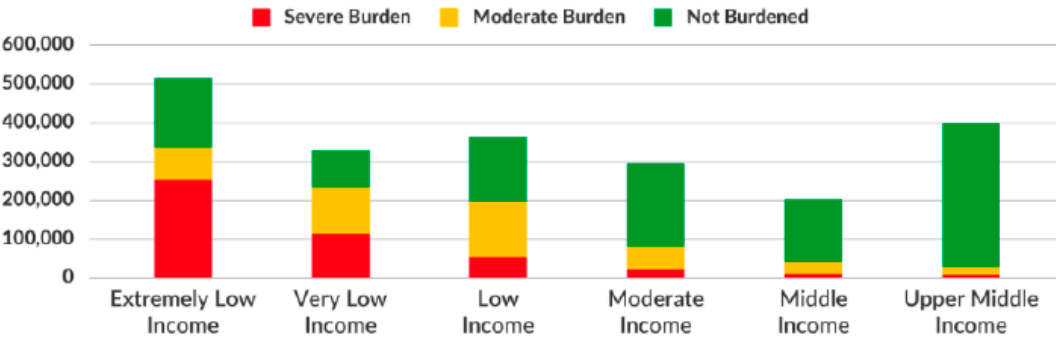
Figure 2. New York City renter households by level of rent burden by income group (2017). Note: Rent burden was calculated using Gross Rent Measure = Gross Rent Paid/Household Income.